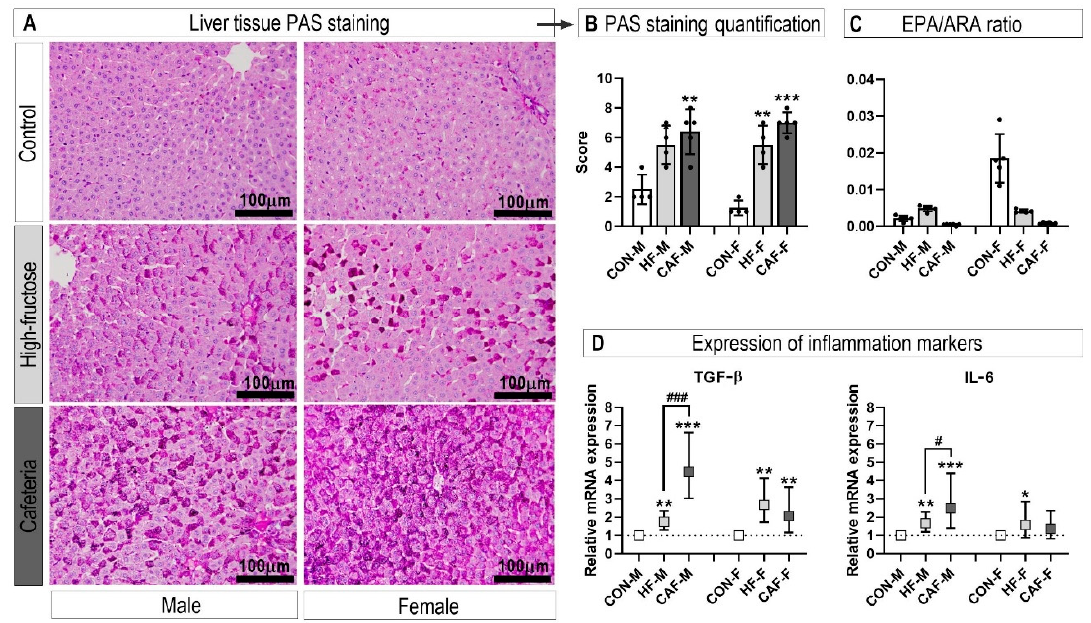
Figure 3. Photomicrographs showing a comparison of the storage products in the livers from the experimental rats ( A ). The appearance of hepatocytes stained with periodic acid-Schiff reagent (PAS), showing glycogen accumulation (glycogen stains magenta and nuclei are blue) and quantification of glycogen accumulation ( B ). Eicosaenoic/arachidonic (EPA/ARA) ratio suggesting a shift to more pro-inflammatory eicosanoids ( C ). The gene expression of the inflammation markers (Transforming growth factor- β and interleukin-6, TGF- β and IL-6) was assessed by the quantitative PCR ( D ). * p < 0.05, ** p < 0.01, and *** p < 0.001 for the treatment versus the Control within the same sex. # p < 0.05, and ### p < 0.001 for the HF diet versus the CAF diet within the same sex. n = 6 for each group. CON, control diet; HF, high-fructose diet; CAF, cafeteria diet; M, males; F, females.